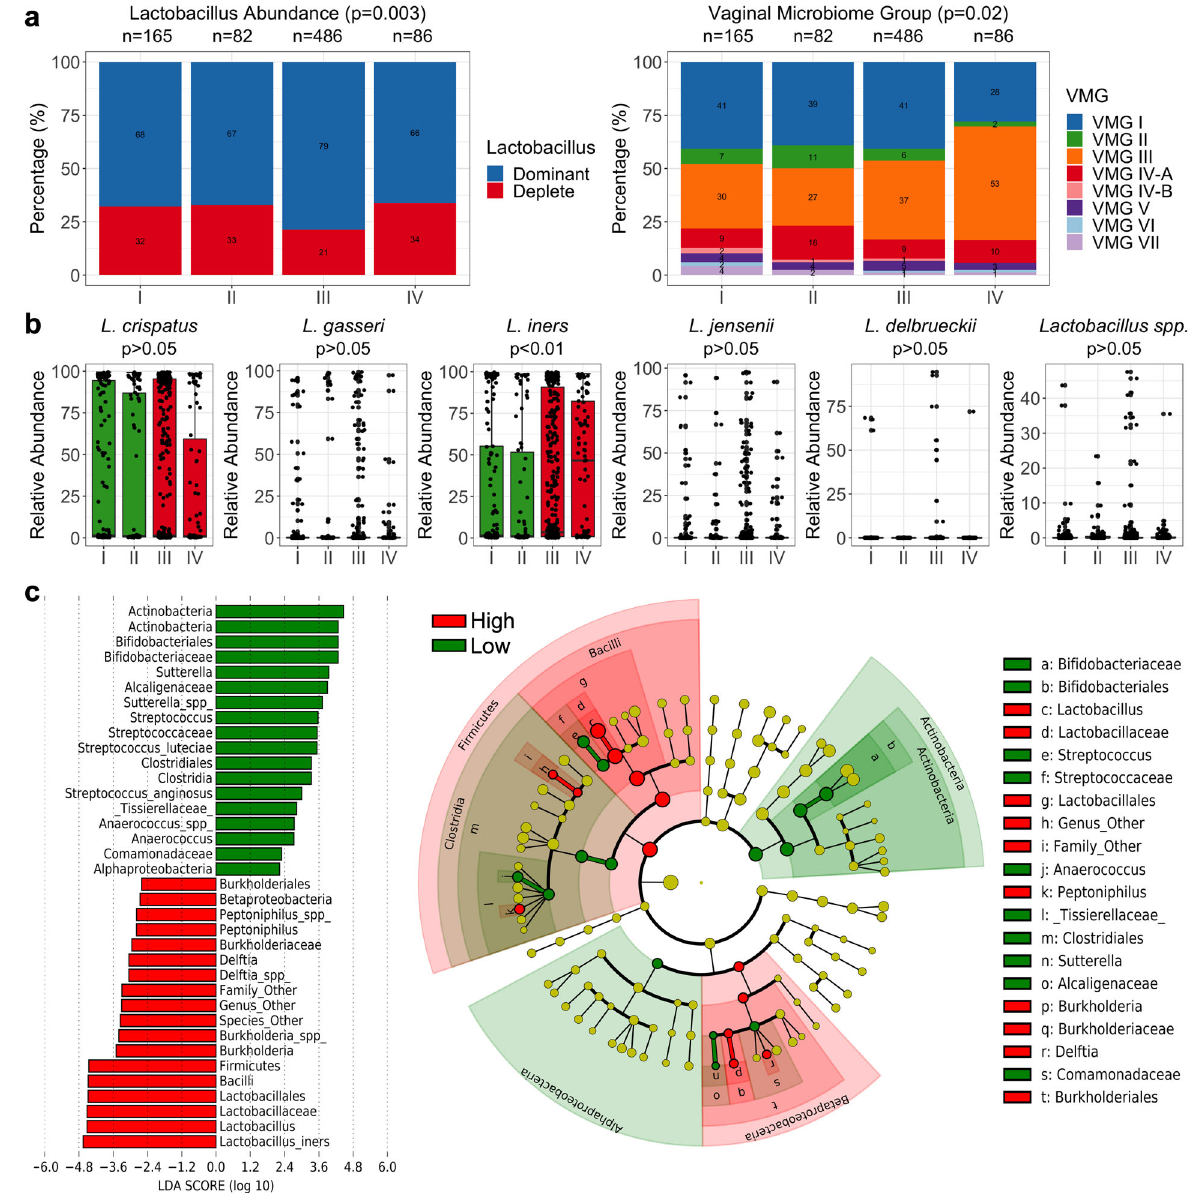
Fig. 3 Vaginal microbiome composition and leukocyte presence. a Stacked bar showing Lactobacillus abundance groups and vaginal microbiome groups (VMG) of women with leukocyte grades of I (0-5 counts/Hp), II (5-15 counts/Hp), III (15-30 counts/Hp) and IV (>30 counts/ Hp). b Boxplots showing relative abundance of L. crispatus , L. gasseri , L. iners , L. jenseni , L. delbruecki , and Lactobacillus spp. in women with leukocyte low (grades I and II, green) and high (grades III and IV, red). The bounds of the box represent the fi rst and third quartiles, center line represents the median, and whiskers show min-to-max values. c LDA of differentially abundant taxa and cladogram displaying bacterial clades and nodes identi fi ed as differentialy abundance from LDA analysis in vaginal microbiota of women with leukocyte low (grades I-II, green) and high (grades III-IV, red). Statistical signi fi cance of categorical variables based on Fisher ’ s Exact Test and continuous variables based on Kruskal- Wallis